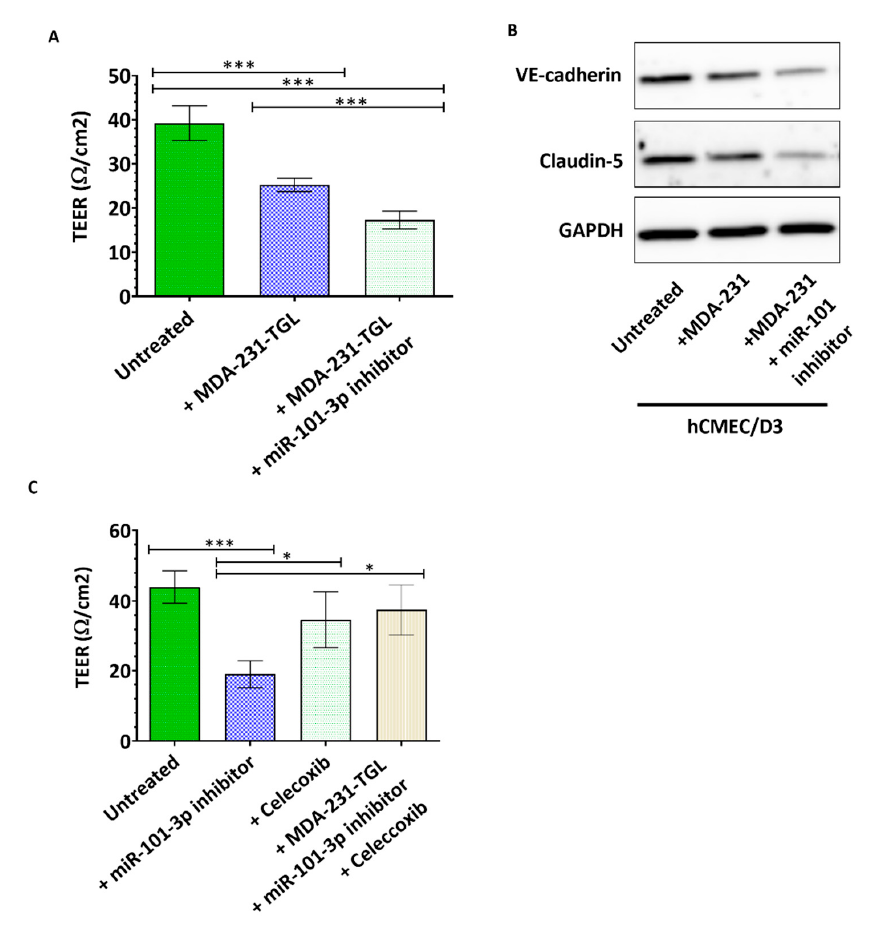
Figure 4. Ectopic downregulation of miR-101-3p in breast cancer cells interferes with brain intercellular junctions.( A , C ) Transendothelial electrical resistance (TEER) was measured for brain endothelial cells co-cultured with MDA-MB-231-TGL cells treated with negative control, miR-101-3p inhibitor and / or celecoxib ( B ) Western Blot analysis of VE-cadherin and claudin-5 protein expression was measured by Western blot in hCMEC / D3 co-cultured with MDA-MB-231-TGL cells treated with miR-101-3p inhibitor or control. Data are mean ± SD from three to six independent experiments. * p < 0.05, *** p < 0.001.